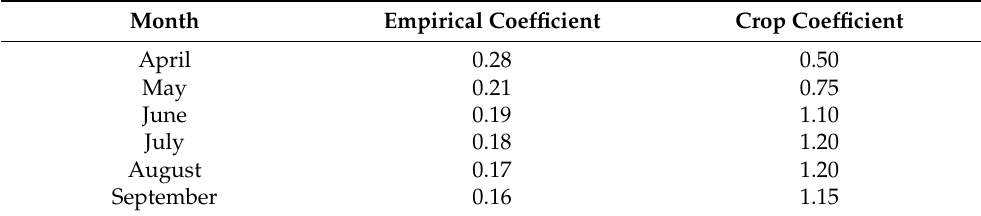
Table 1. Values of the empirical coefficient and crop coefficient for sweet cherries according to Treder